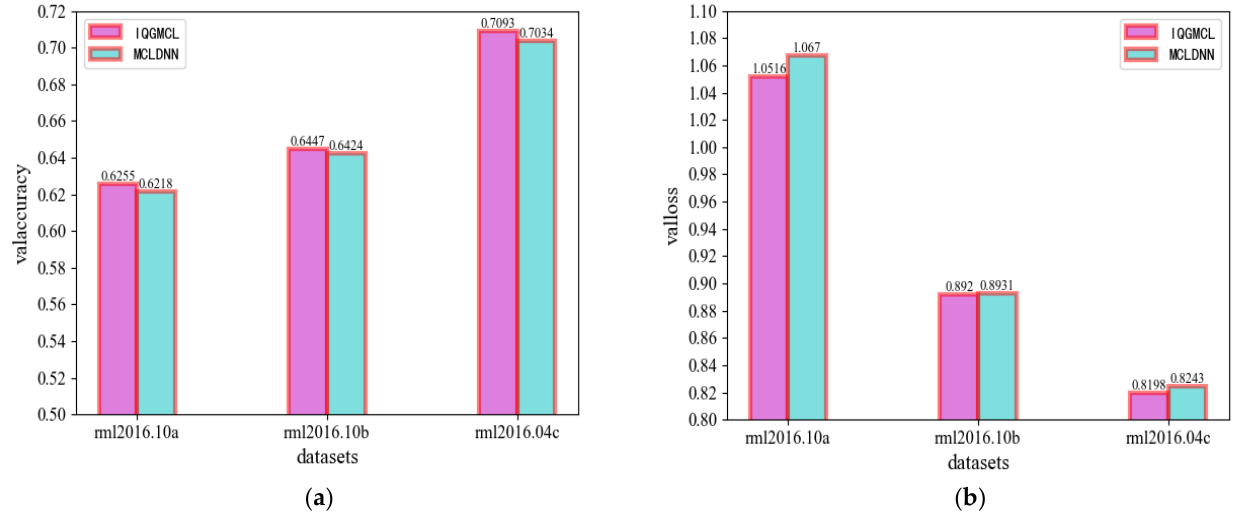
Figure 9. Val-accuracy and Val-loss contrast of two networks. ( a ) Val-accuracy contrast; ( b ) Val-loss contrast.